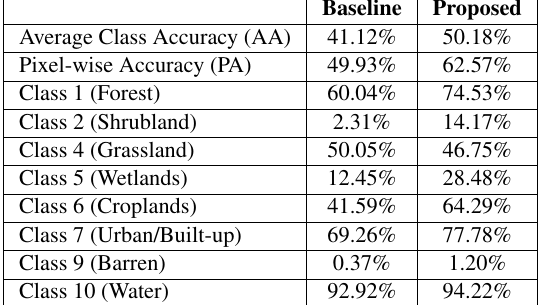
Figure 8: Misclassifications of rivers and wetlands